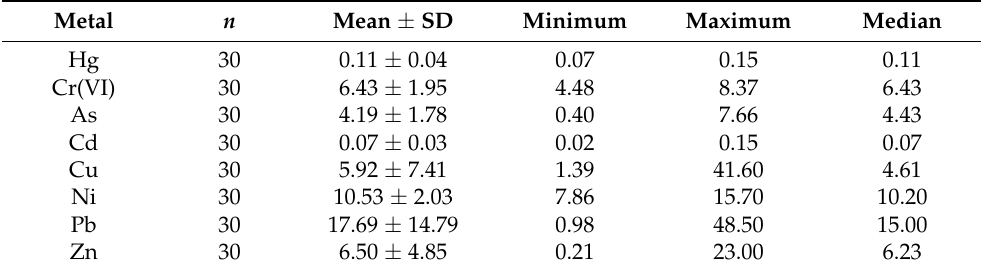
Table 3. Concentrations of heavy metals in the surface water of Taihu Lake ( µ g · L − 1 ).